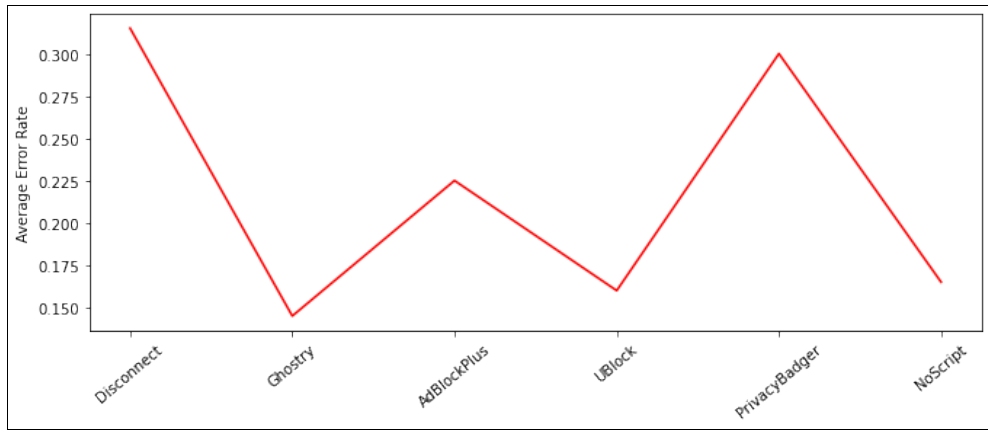
Figure 6. The average error rate (AER) of the